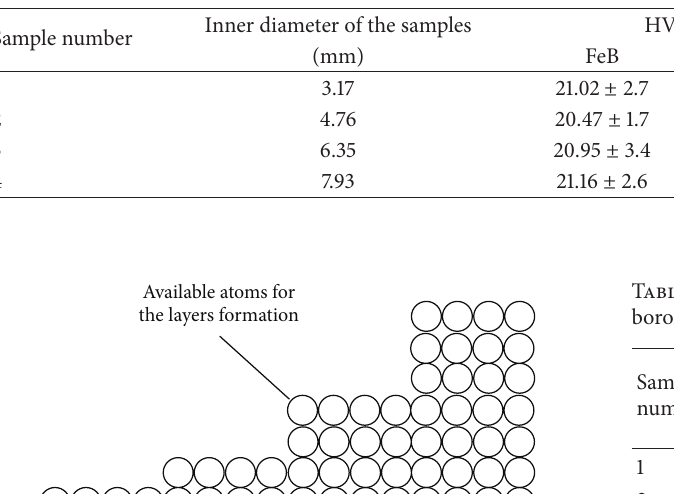
Figure 8: Behavior of the (a) hardness and (b) Young’s modulus of the FeB and Fe 2 B phases as a function of the boron potential represented by the inner diameter of the samples. Table 4: Behavior of the hardness and Young’s modulus of the FeB and Fe inner diameter of the samples.